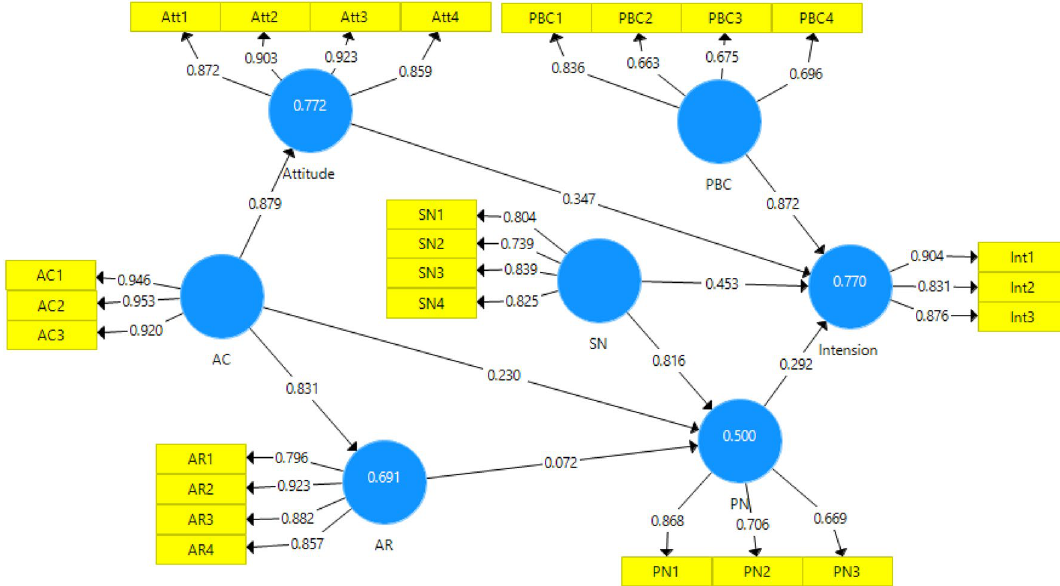
Figure 3. Path model with standardized factor loadings.